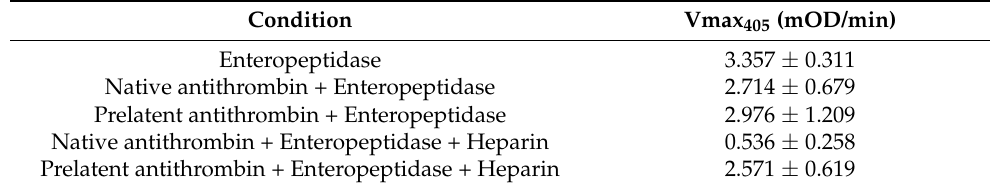
Table 1. Enteropeptidase activity using its chromogenic substrate after incubation with antithrombin.